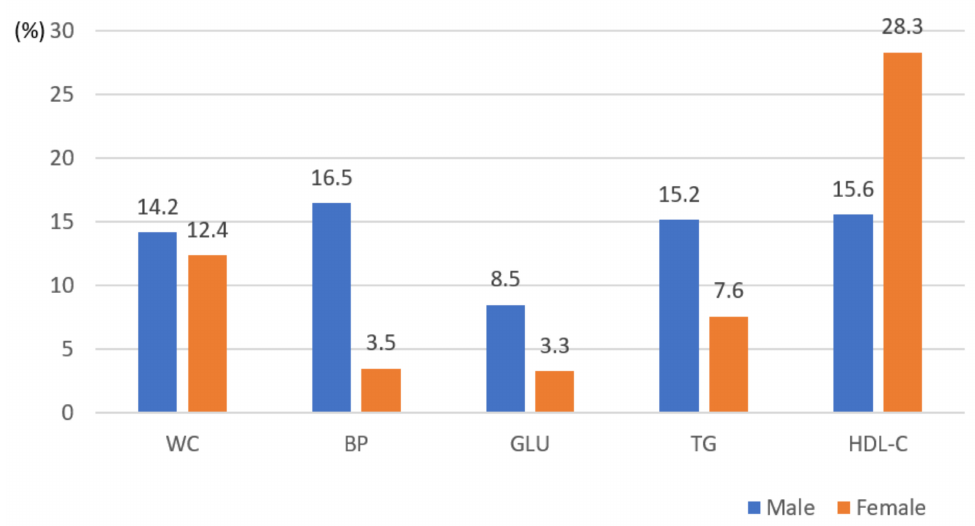
Figure 1. Association between individual metabolic syndrome components and sex (n = 1310).